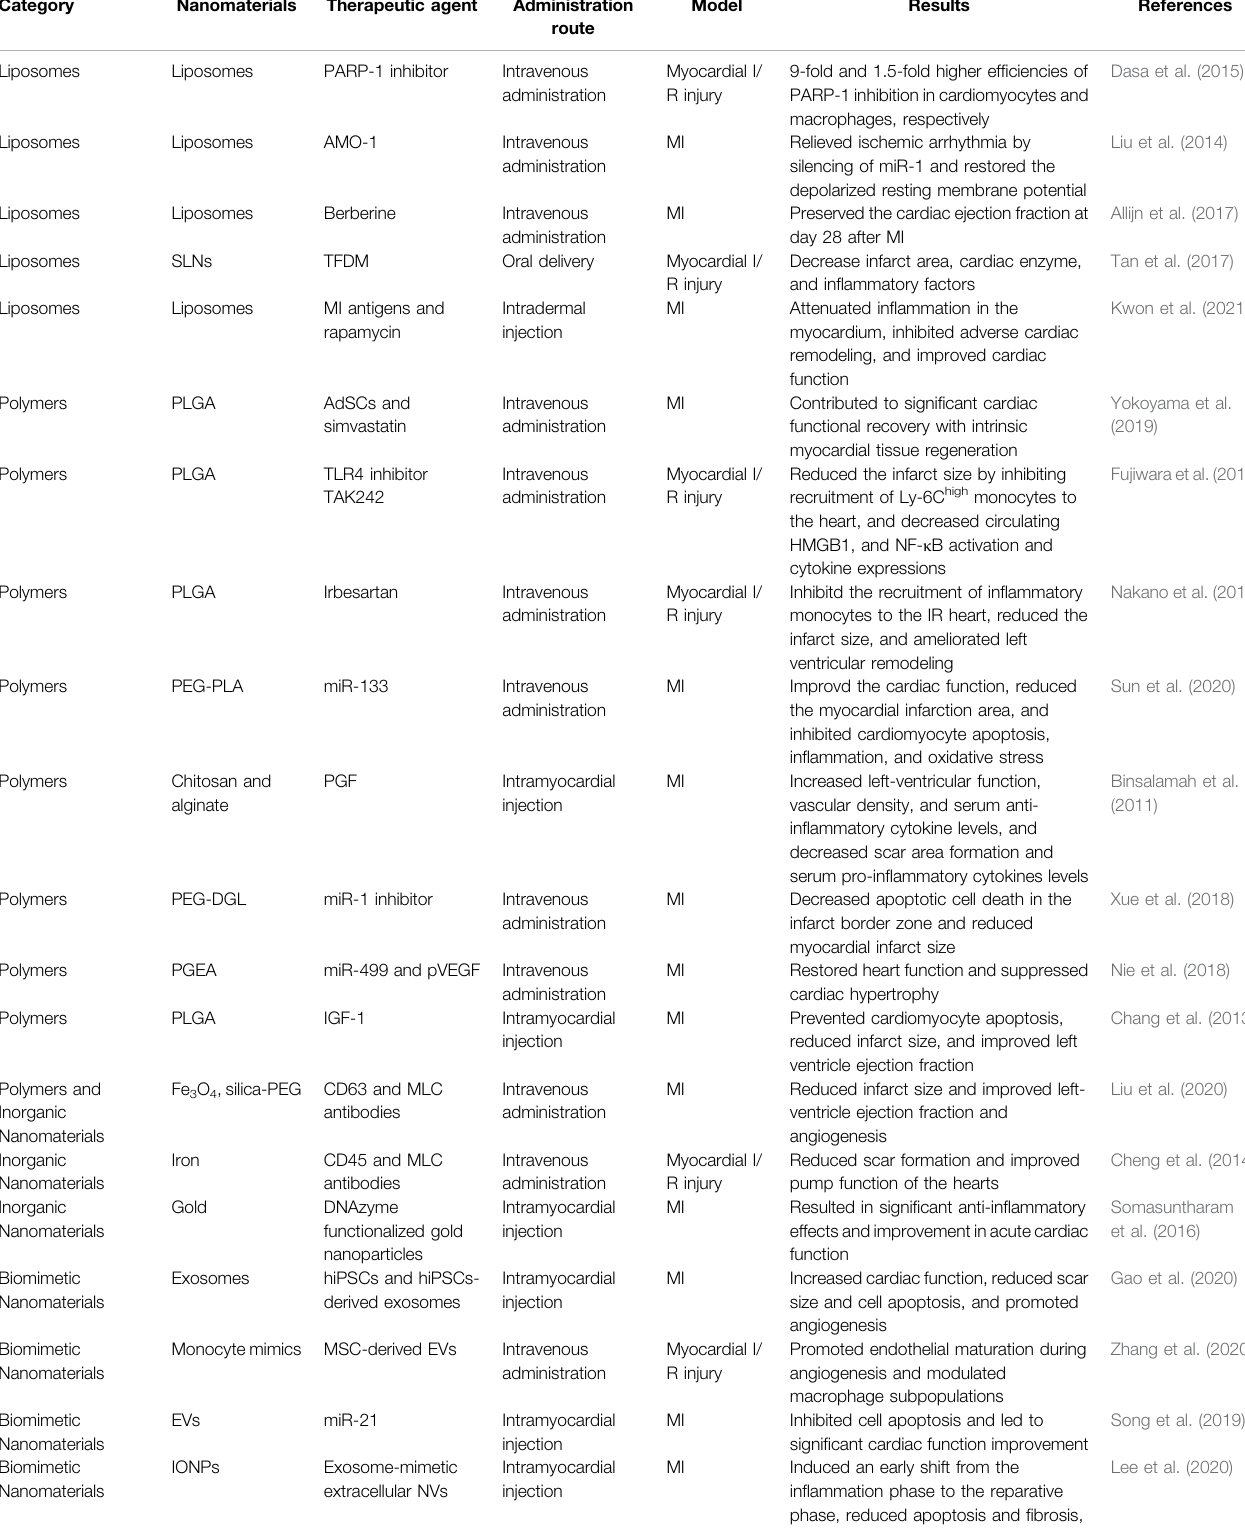
TABLE 1 | Summary of the nanomaterials used for the therapy of